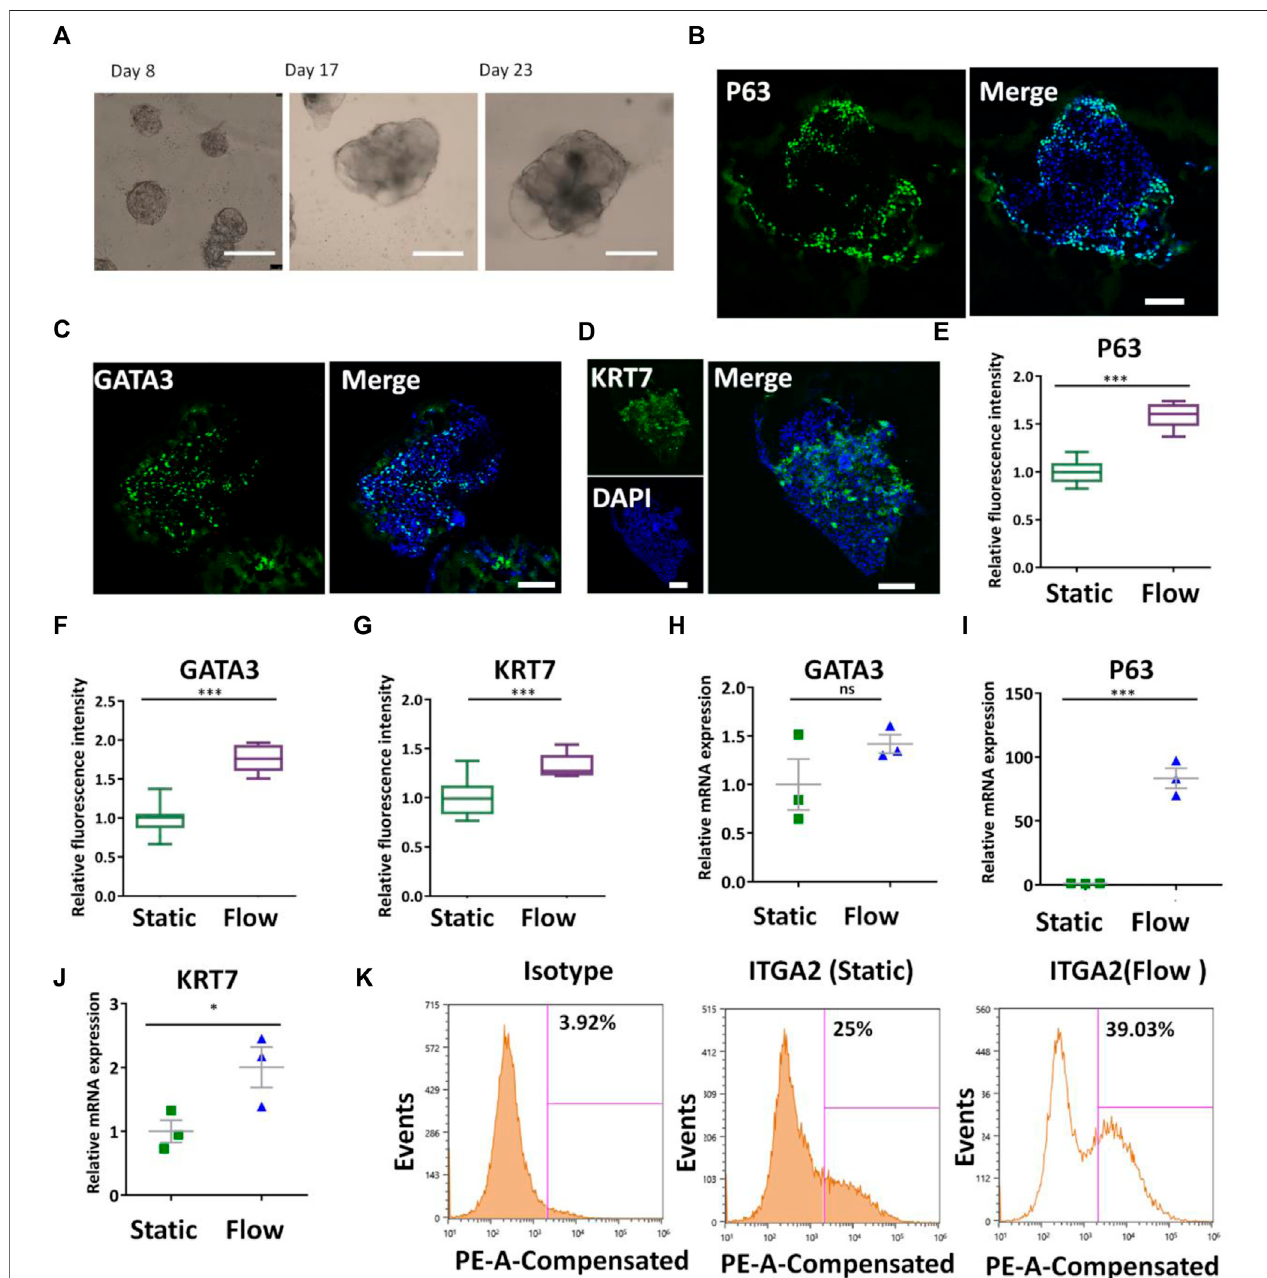
FIGURE 3 | Differentiation of CTBs in the formed tissues under dynamic conditions. (A) Bright- fi eld images of the growth of 3D tissue on different days (8, 17, and 23) after exposure to a medium with a cocktail of de fi ned factors at the perfusion of 1 ml/min. Scale bars, 200 μ m. (B – D) Immuno fl uorescence image of the analysis of CTB markers P63, GATA3, and KRT7 under dynamic conditions. Scale bars, 100 μ m. (E – G) P63 + , GATA3 + , and KRT7 + cells were quanti fi ed in 3D tissues under static and dynamic conditions. The data are indicated as mean ± SEM ( n > 3). (H – J) Expression levels of P63, GATA3, and KRT7 genes in 3D tissues under different conditions were probed by qRT-PCR. Data were mean ± SEM ( n = 3). GAPDH was used as the reference gene. (K) ITGA2 + cell population in 3D tissues under different culture conditions was quanti fi ed by fl ow cytometry analysis. The data were analyzed using Student ’ s t- test (* p < 0.05; ** p < 0.01; and *** p <